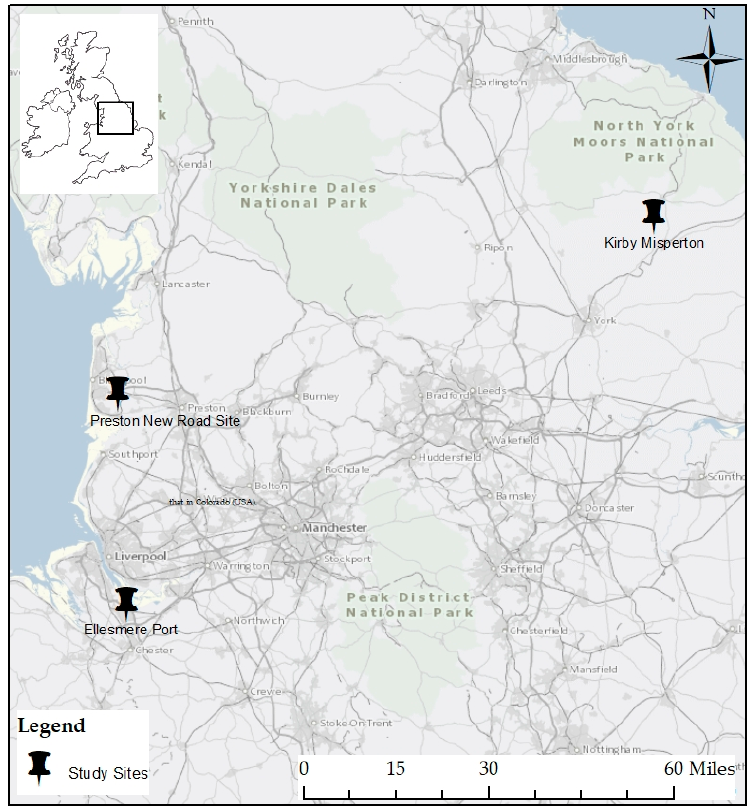
Figure 1. Map of study locations.